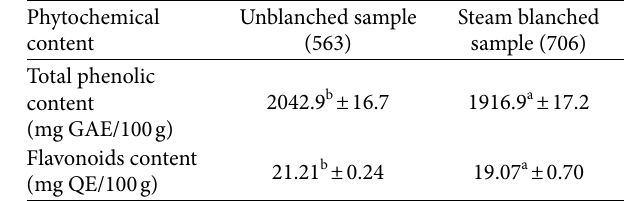
; mean ± SD. Values in a row followed by different letters in superscript 푛 = 3 are significantly